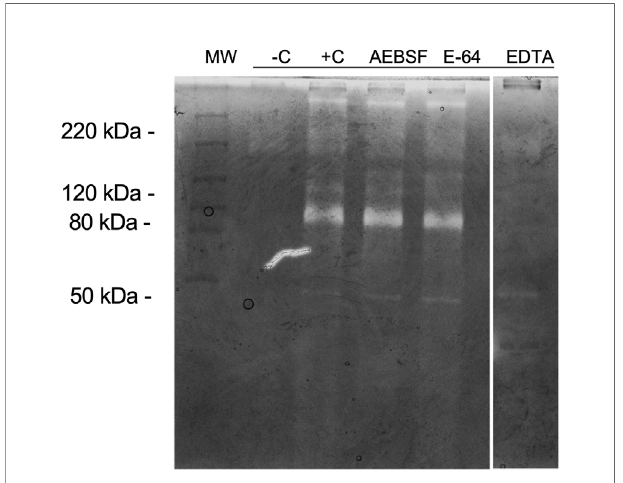
FIGURE 3 | Inhibition of proteolytic activity in gelatin zymography. Protease activity analysis of 10 m l SWS proteins (per lane). Gel strips (8% polyacrylamide with 0.1% gelatin, w/v) were incubated in the presence of AEBSF (1 mM), E-64 (100 µM) or EDTA (1 mM). Strips were stained with Coomassie Brilliant Blue R250. Clear bands on dark background indicate sites of protein degradation. -C: Boiled SWS. Molecular weight markers